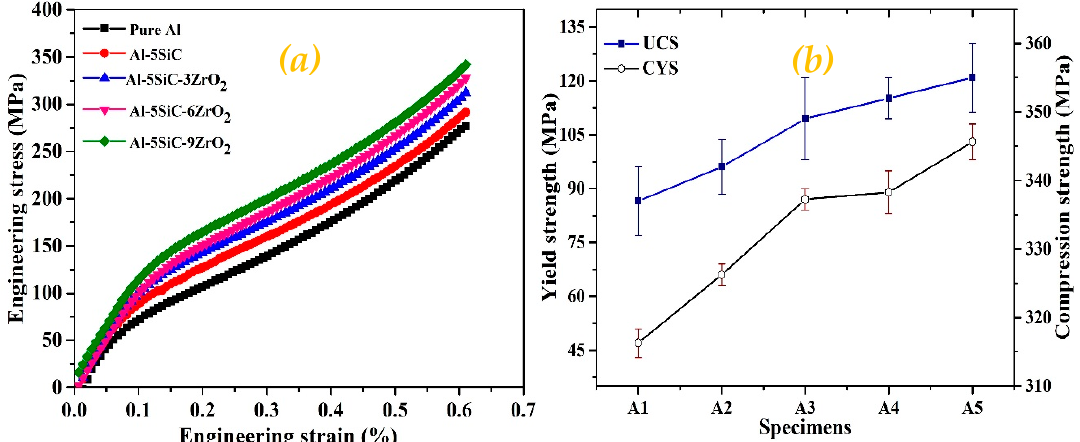
Figure 7. ( a ) Compressive curves, ( b ) compressive yield strength (CYS) and ultimate compressive strength (UCS) of pure Al and the developed Al-SiC-ZrO 2 nanocomposites.